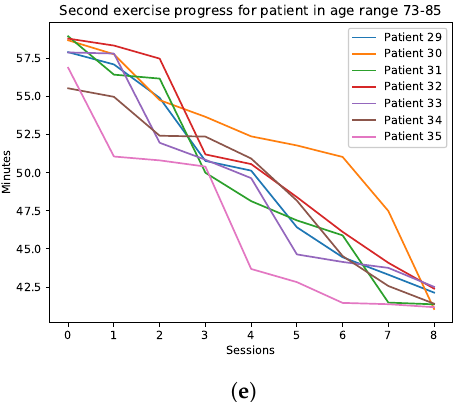
Figure 16. The performance of the patients for the last exercise. The plots are divided by age: ( a ) 25–36,